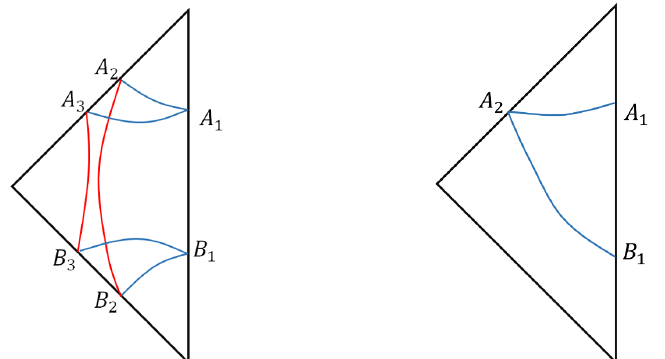
Figure 1 . Penrose diagrams on Poincaré patch of AdS 3 spacetime and geodesics connecting ∂A . Left panel: the blue solid curves A 1 A 2 and B 1 B 2 stand for the space-like geodesics used in ref. [15] and the red solid curve A 2 B 2 stands for the time-like geodesic. The blue solid curves A 1 A 3 and B 1 B 3 and the red solid curve A 3 B 3 stand for other possible geodesics. Right panel: using two space-like geodesics to connect the endpoints of time-like interval A